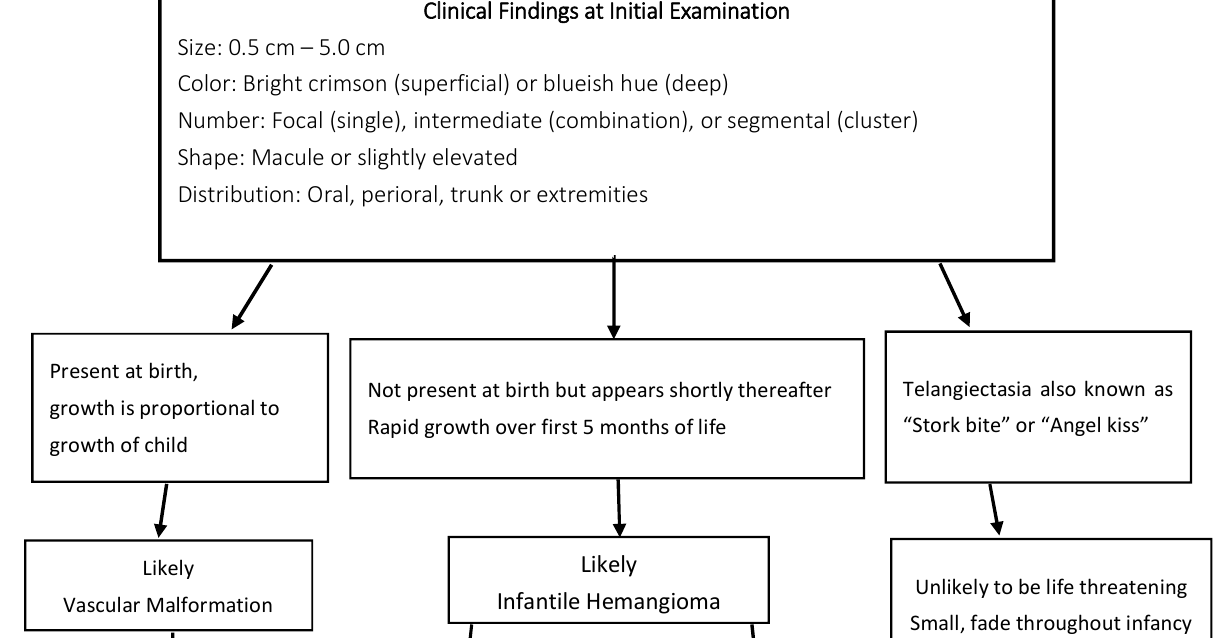
Table IH DECISION TREE